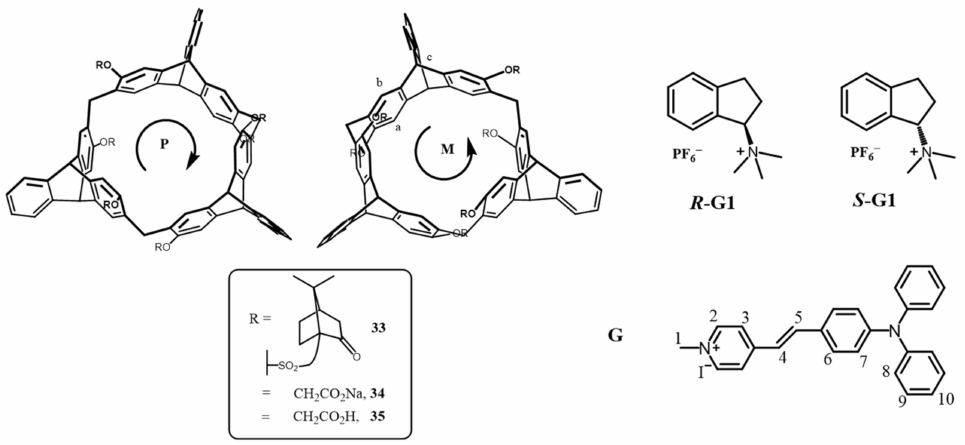
Figure 13. The enantiomer of 33 , 34 and 35 . The chemical structure of G1 and G